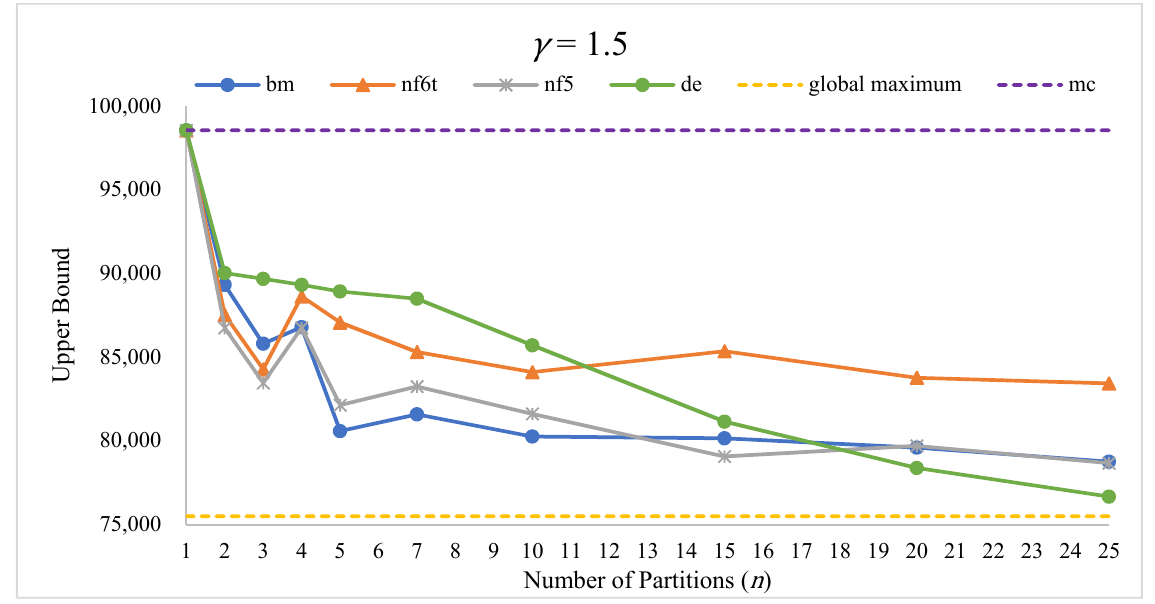
Figure 7 . Convergence-indicating curves of the bm, de, nf5, and nf6t relaxation schemes for 𝛾 = 1.5.